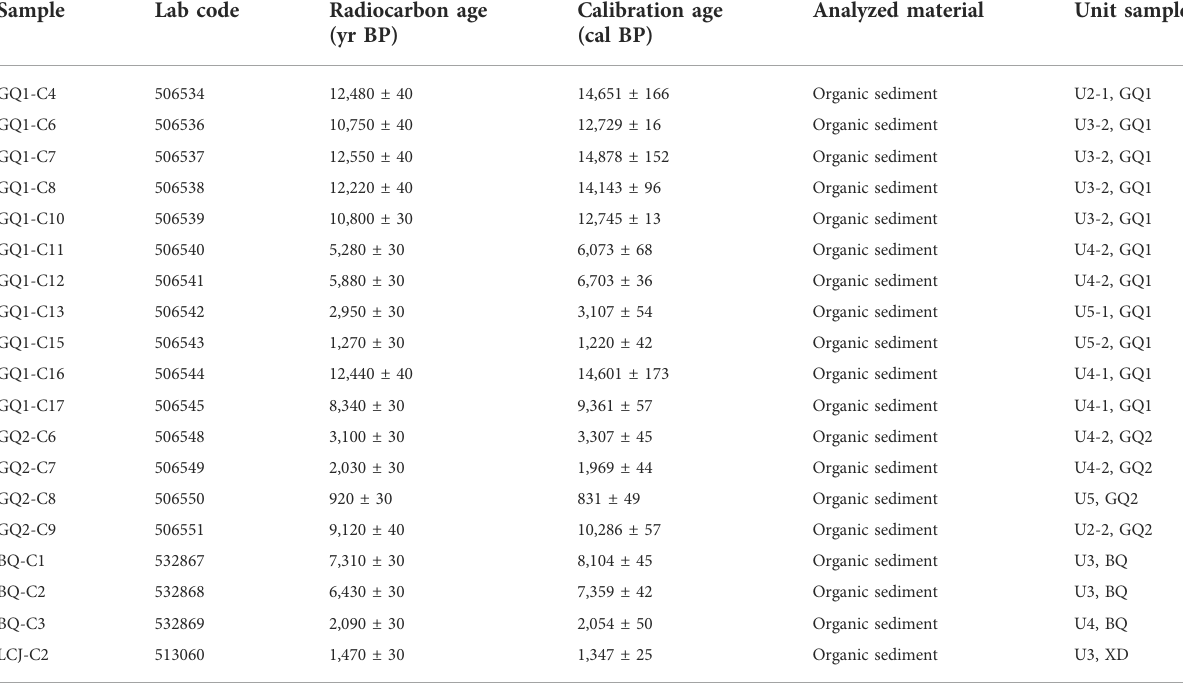
TABLE 5 Radiocarbon samples and dating results for the three trenches and one outcrop.